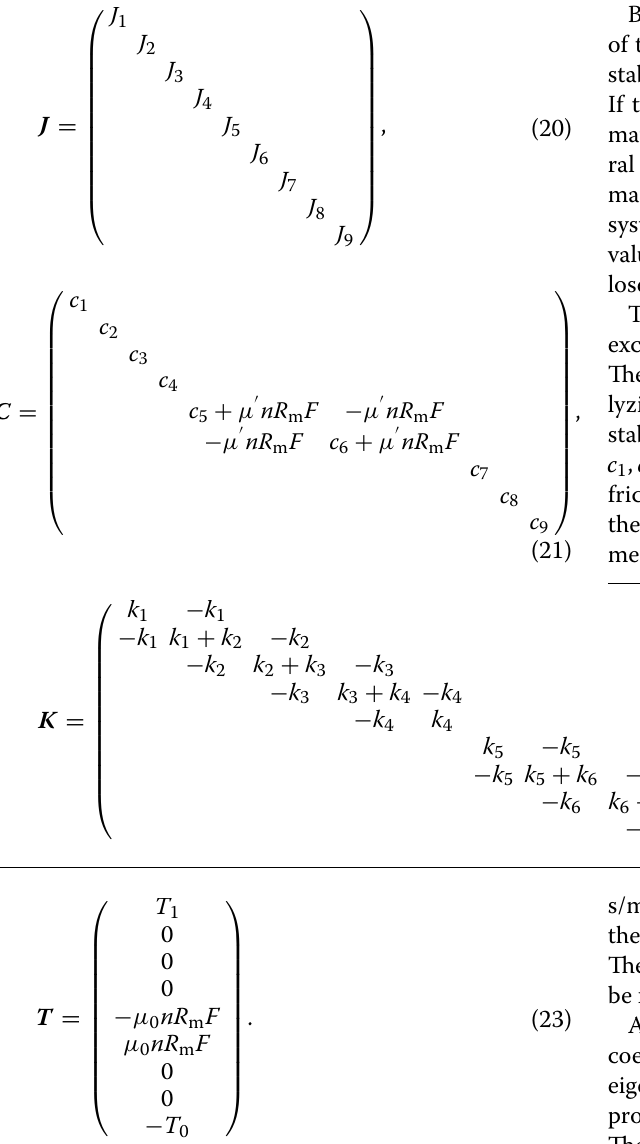
Gradient Based on MATLAB / Simulink software, the gradient val- ues of the friction coefficient are selected as 0.005 s/m, 0 s/m and 0.005 s/m for the simulation. The − simulation results are shown in Figure